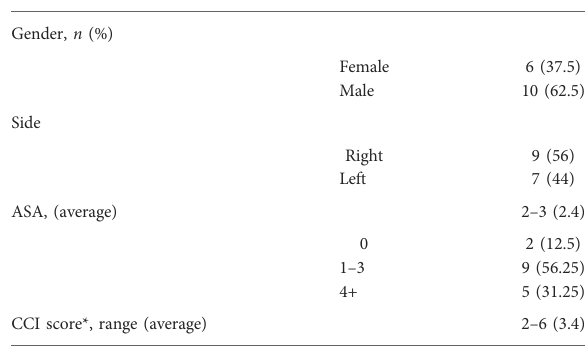
TABLE 2 Patient demographics.